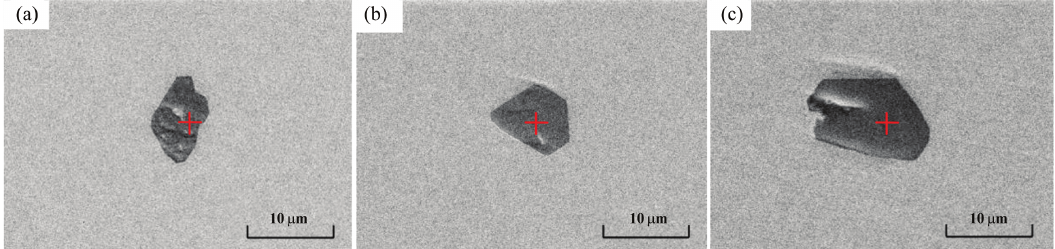
Figure 10: The AlN inclusions near the tensile fracture deformed at (a) 700°C, (b) 800°C and (c) 900°C with SEM.